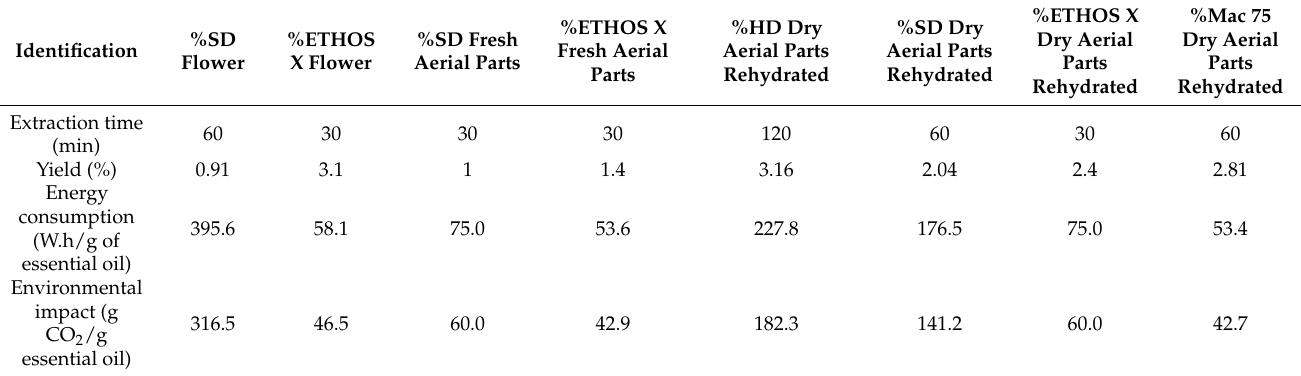
Table 3. Extraction time, yield, energy consumption, and environmental impact of Thymus mastichina essential oils obtained using steam distillation (SD), hydrodistillation (HD), and solvent-free microwave extraction (SFME) at laboratory (ETHOS X) and pilot scale (Mac 75) with the use of flowers and fresh and dry aerial